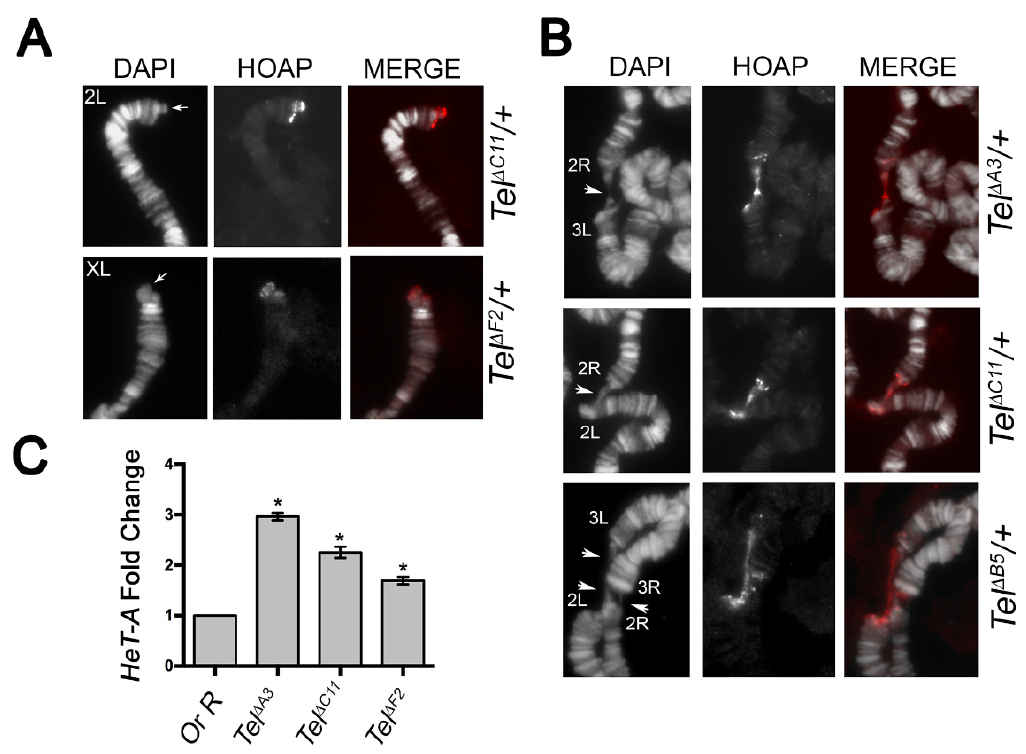
Figure 7. Telomere elongation in the CRISPR/Cas 9-induced Tel deletion alleles. ( A ) anti-HOAP immunostaining on 2L and XL chromosome tips from Tel ∆ F2 /+ and Tel ∆ C11 /+ hemyzygotes, respectively, showing protruding telomeric DNA only on the Tel mutant chromosomes (arrows). Note that, as expected, Tel mutant elongated telomeres do not impair HOAP localization. ( B ) Examples of telomere fusions involving either two or four chromosome tips (arrowheads) from different Tel ∆ hemizygotes. ( C ) qPCR analysis on third instar larval DNA from two representative Tel ∆ deletion alleles showing a robust increase in Het-A copy number compared to control (OR-R). Note that Tel ∆ B5 bears a deletion that uncovers TGT, while Tel ∆ C10 does not include TGT. * ( p < 0.05).